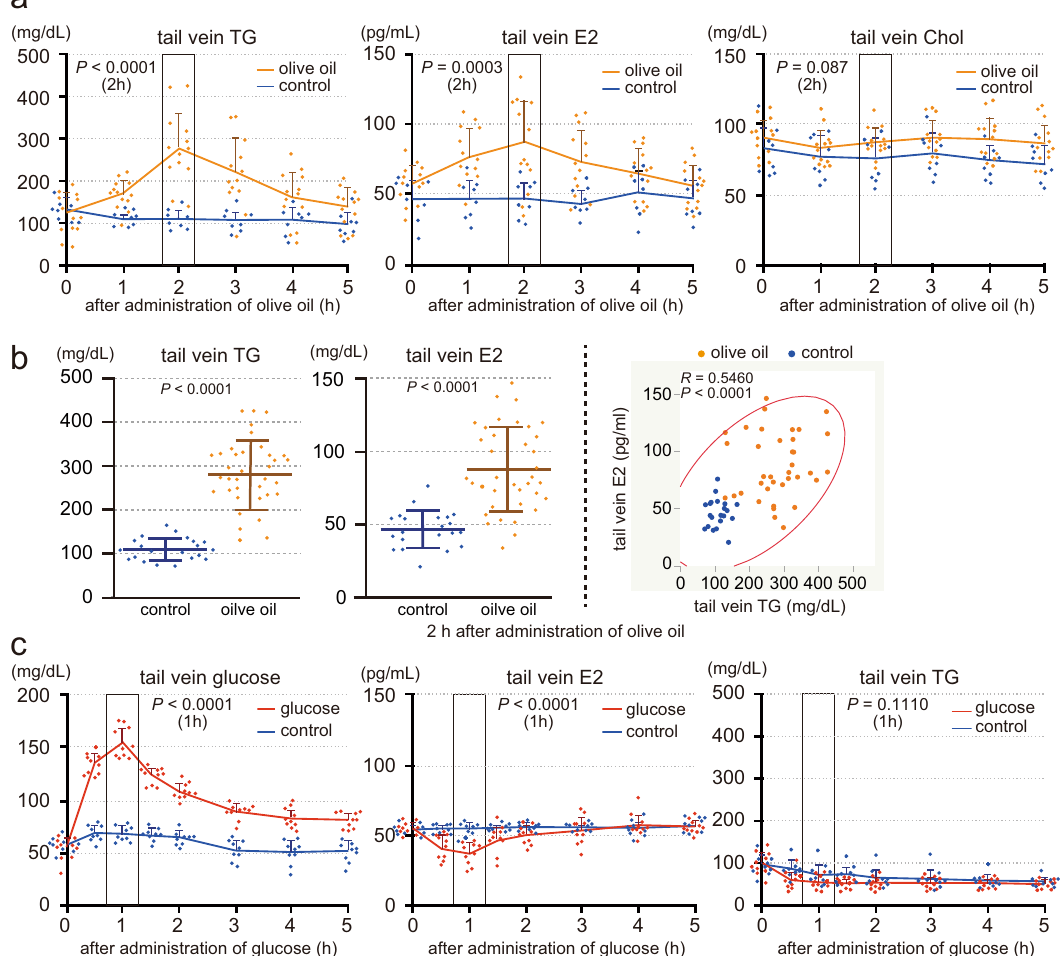
Fig. 2 Blood estrogen levels increase as blood triglyceride levels rise in males. a and b Male rats (8 weeks old, deprived of food for 4 h) were orally administered olive oil (2.5 mL per kg body weight) or control water (control) using the gavage technique. Triglyceride (TG), E2 and cholesterol (Chol) levels in the tail venous blood were measured before (0) and at 1, 2, 3, 4, 5 h after the administration (olive oil: n = 13, control: n = 8, a ). TG and E2 levels in the tail venous blood were measured at 2 h after the administration (olive oil: n = 37, control: n = 21, b , left), and the correlation diagram between the blood TG and E2 levels ( n = 58, b , right). c Male rats (8 weeks old, deprived of food for 18 h) were orally administered glucose (2 g per kg body weight, n = 10) or control water ( n = 9). Glucose, E2, and TG in the tail venous blood were measured before (0) and at 0.5, 1, 1.5, 2, 3, 4, and 5 h after the administration. n number of rats. Data were mean ± s.d. P values determined by two-sided Student ’ s t -test at 2 h ( a , b , left) or 1 h ( c ) after the administration. b , right, R and P values determined by Pearson ’ s product-moment correlation with 95% density